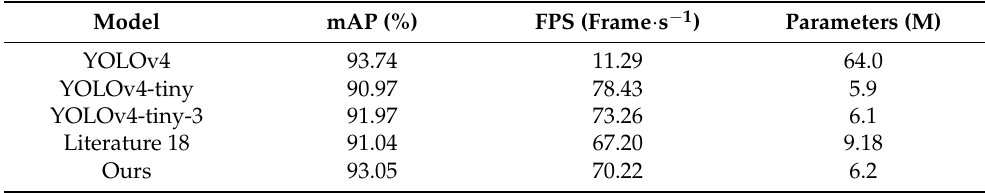
Table 3. mAP, FPS and the number of parameters for different